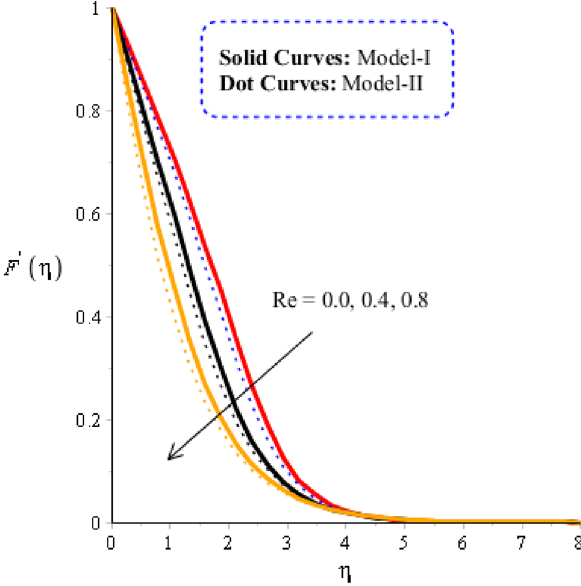
Figure 5. Graphical impact of Re on velocity distribution when α = 0.5, m = 0.3, we = 3.0, M = 3.0, Pr = 206, H